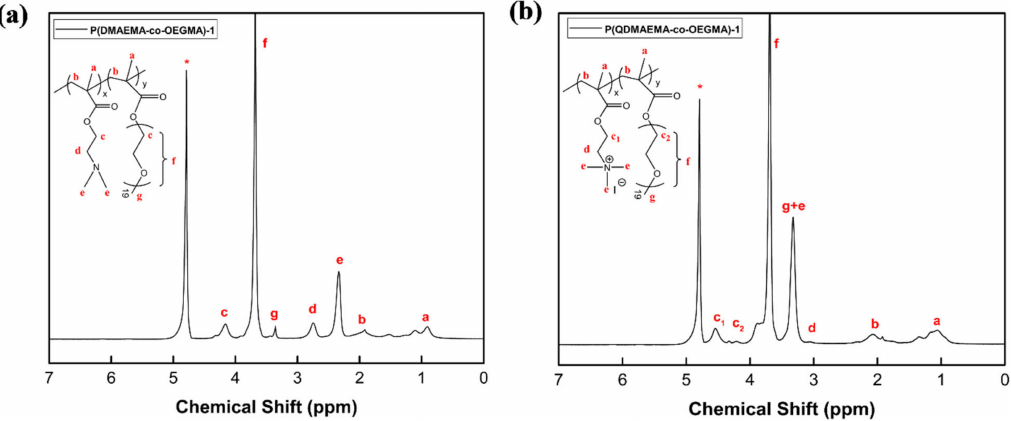
Figure 2. Representative 1 H-NMR spectra of ( a ) P(DMAEMA-co-OEGMA)-1 and ( b ) P(QDMAEMA- co-OEGMA)-1 copolymers in D 2 O. The asterisk at 4.79 ppm denotes the peak of the solvent.